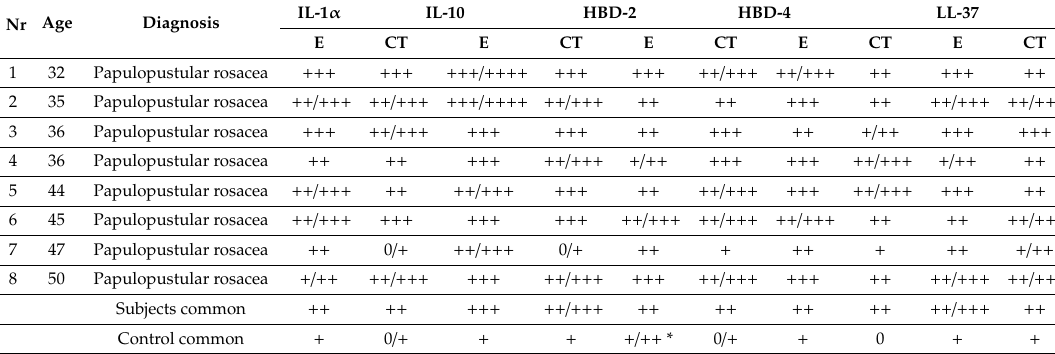
Table 1. Relative number of cytokines, defensins, and cathelicidin-positive structures in the rosacea- affected facial epithelium and subepithelium.